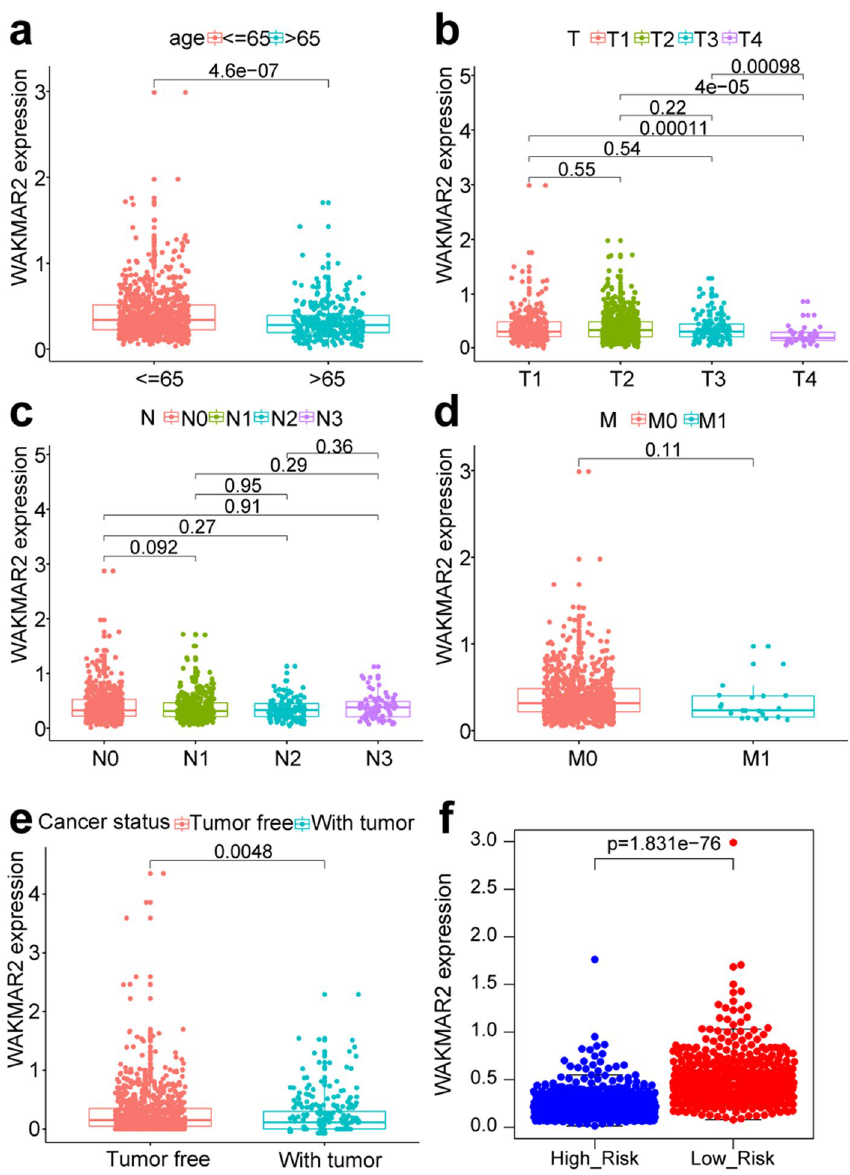
Figure 3. Relationship between WAKMAR2 expression and clinical characteristics, in detail, N represents the degree of spread to regional lymph nodes, including N0: no regional lymph nodes metastasis, N1: regional lymph node metastasis present; at some sites, tumor spread to closest or small number of regional lymph nodes, N2: tumor spread to an extent between N1 and N3 (N2 is not used at all sites), and N3: tumor spread to more distant or numerous regional lymph nodes; T represents the size or direct extent of the primary tumor, in which the T1, T2, T3, T4 stands for the size and extension of the primary tumor; M represents the presence of distant metastasis, including M0: no distant metastasis, and M1: metastasis to distant organs (beyond regional lymph